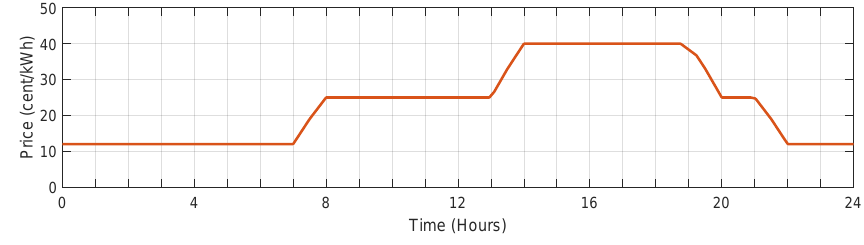
Figure 5. Hourly electricity price signal.